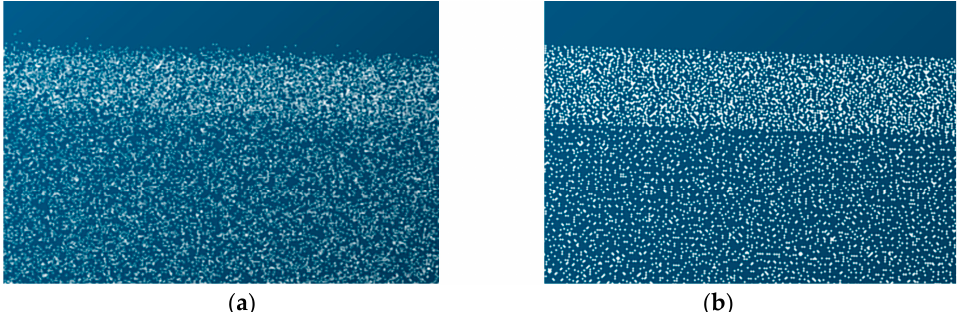
Figure 8. Comparison of Details Before and After Denoising: ( a ) the point cloud before denoising; ( b ) the point cloud after denoising.